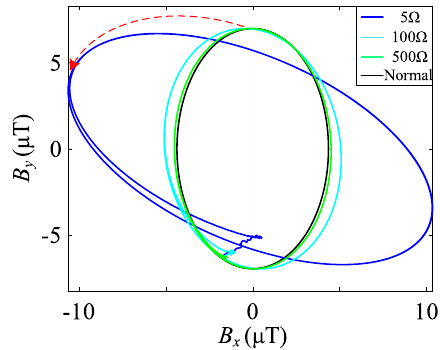
Fig. 18 Magnetic field trajectory downstream of the fault point under different grounding impedances